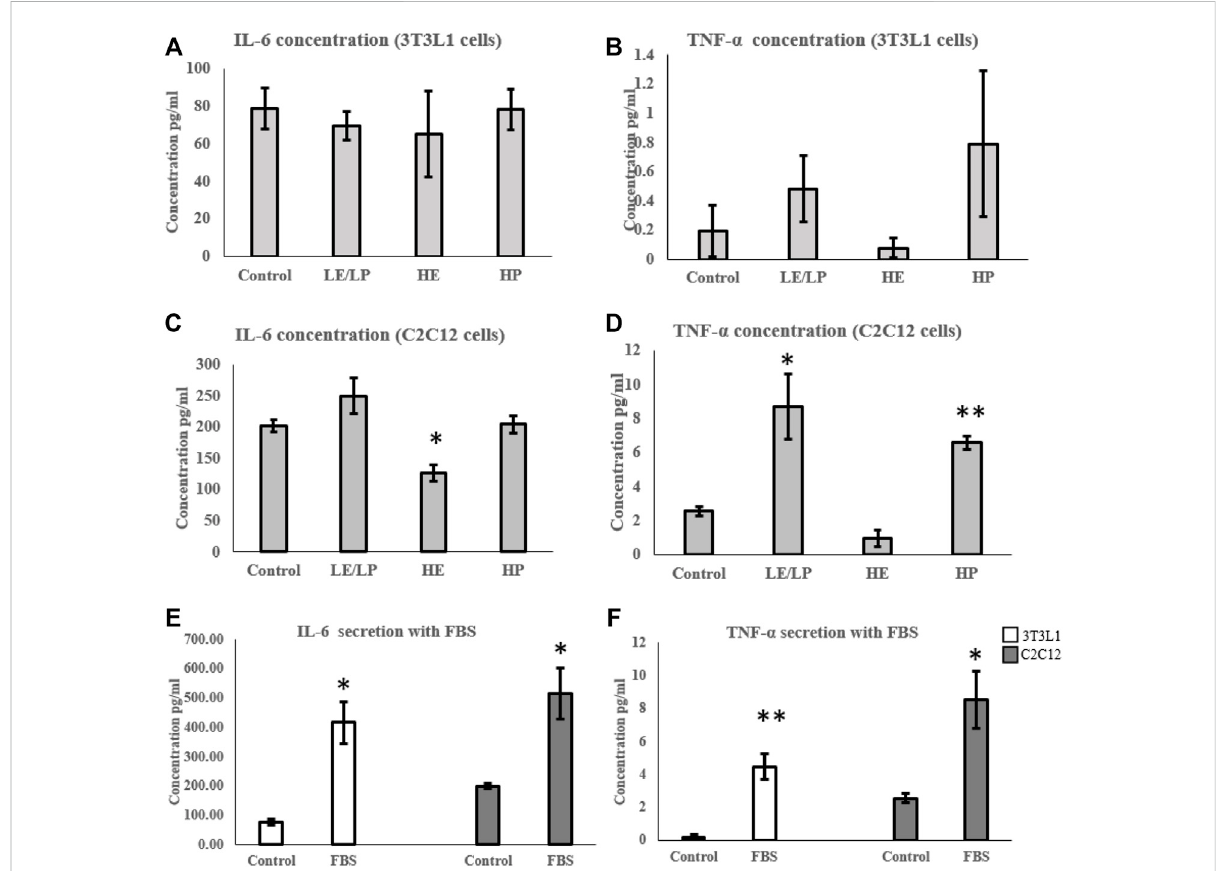
FIGURE 1 Effect of incubating 3T3-L1 (A,B) and C2C12 (C,D) cells with 10% of sera from different athlete groups (LE/LP: low endurance/low power, HE: highendurance,andHP:highpower)onIL-6andTNF- α secretion.Theeffectofincubating3T3-L1andC2C12cellswithFBSonthesecretionofIL-6 (E) and TNF - α (F) . Data are presented as mean ± SEM (* p ≤ 0.05, ** p ≤